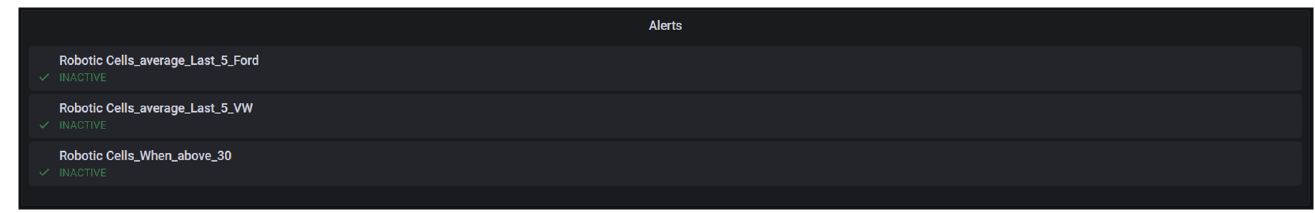
Figure 18. Alert panel.